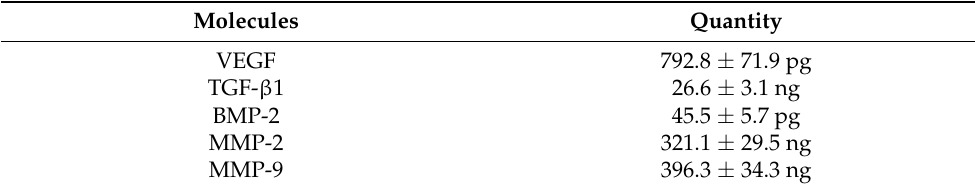
Table 2. Growth factors and MMPs extracted from CGF.